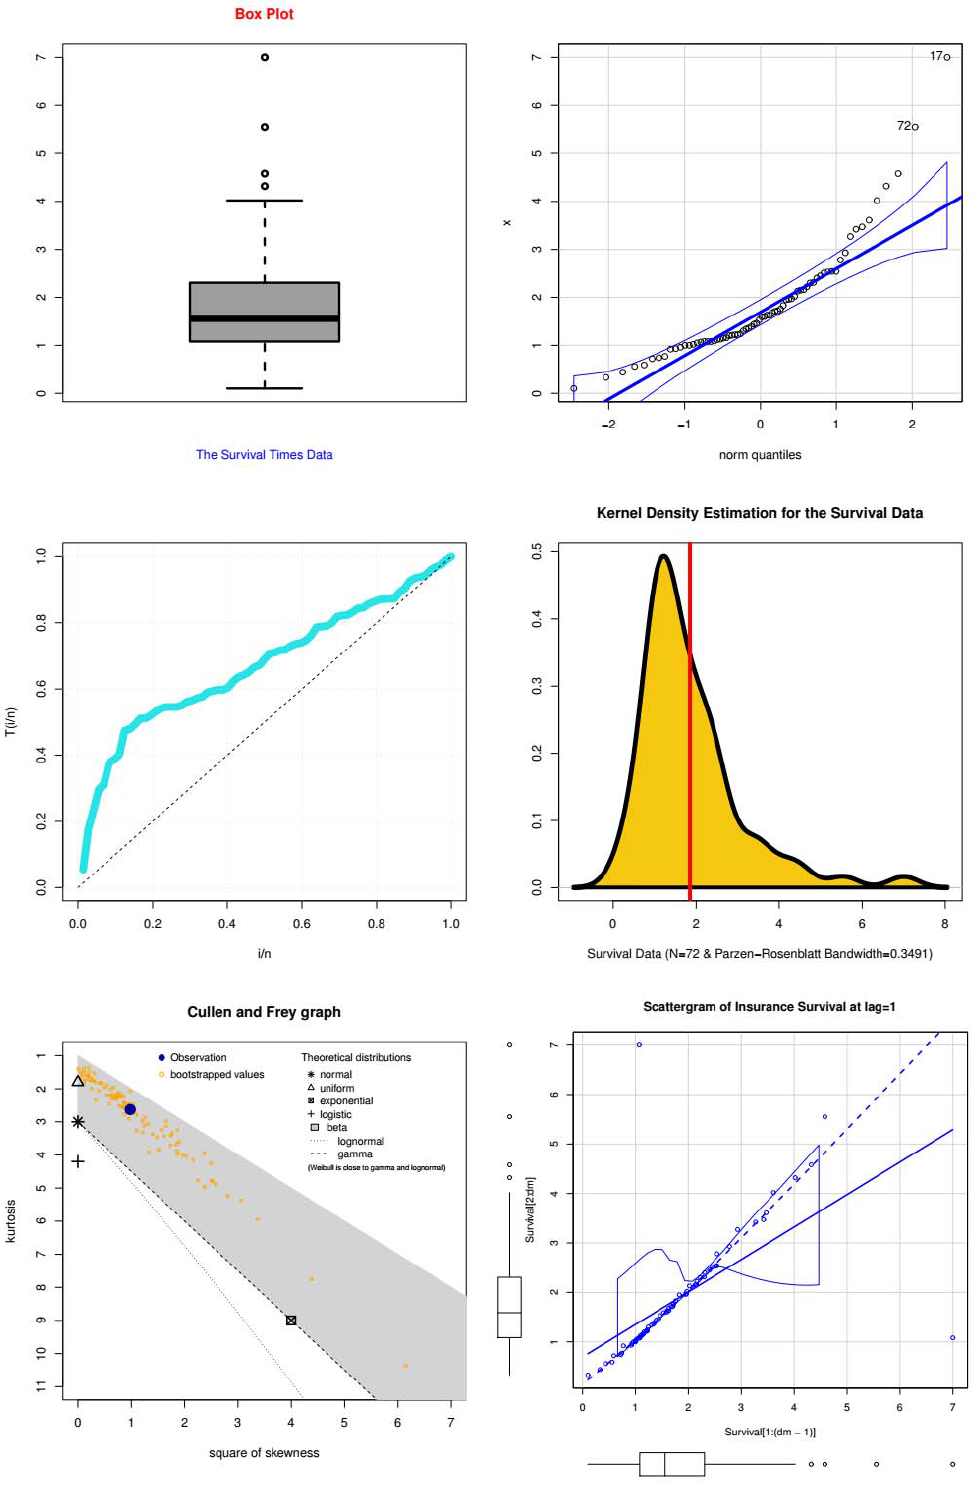
Figure 5. The box pot ( top left ), Qu–Qu plot ( top right ), TTT ( bottom left ), N-KDE ( bottom right ), Frey ( bottom left ), and scattergram ( bottom right ) for the survival times.